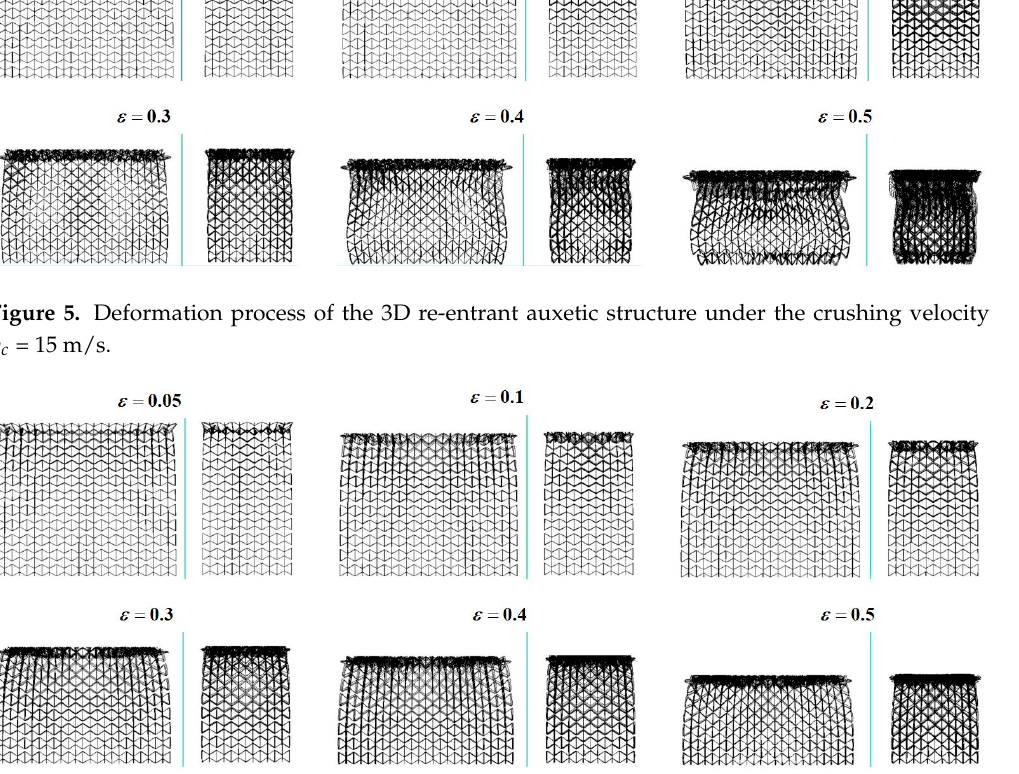
Figure 5. Deformation process of the 3D re-entrant auxetic structure under the crushing velocity 𝑣 (cid:3030) = 15 m/s.